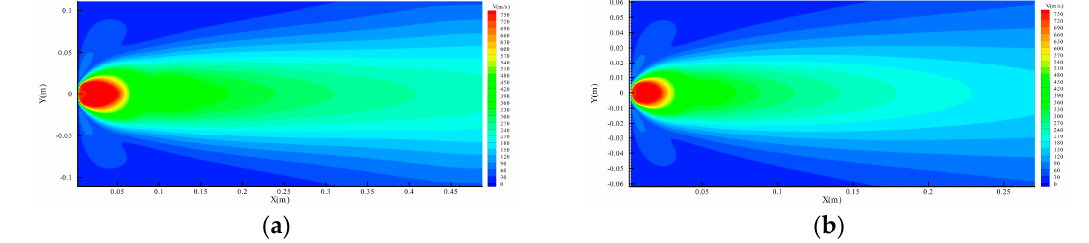
Figure 8. Velocity contour of different leak hole diameter. ( a ) 1 mm; ( b ) 0.5 mm.